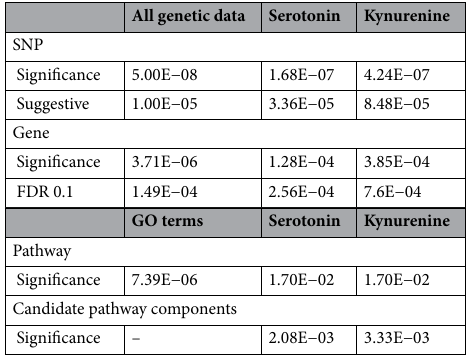
Table 4. Corrected significance thresholds used in the study. FDR denotes false discovery rate. Serotonin and Kynurenine pathways refer to our main candidate pathways. GO terms refer to Gene Ontology terms. Candidate pathway components refer to the corresponding candidate subpathways. Serotonin pathway components: Serotonin GO, GO—serotonin receptor signalling pathway, GO—serotonin metabolic process, GO—serotonin binding, Reactome GPCR downstream, Reactome serotonergic, Serotonin WP; Kynurenine pathway components: Kynurenine ChEMBL, Kynurenine GO, Kynurenine WP, Kynurenine